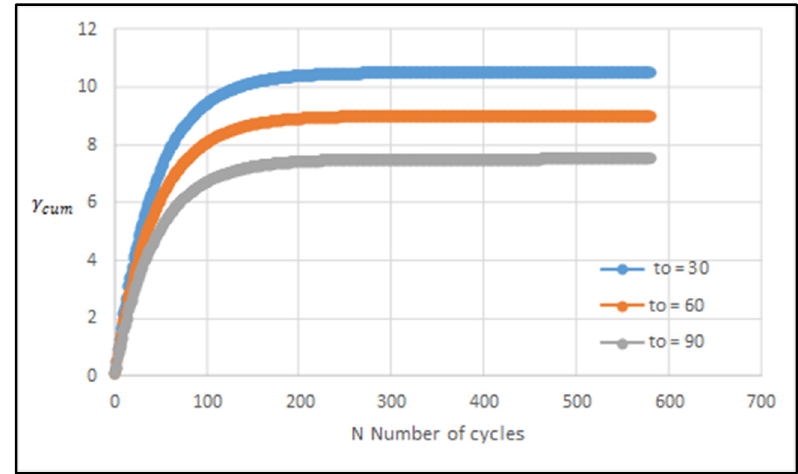
Figure 7. Effect of isotropic hardening ( τ o parameter).